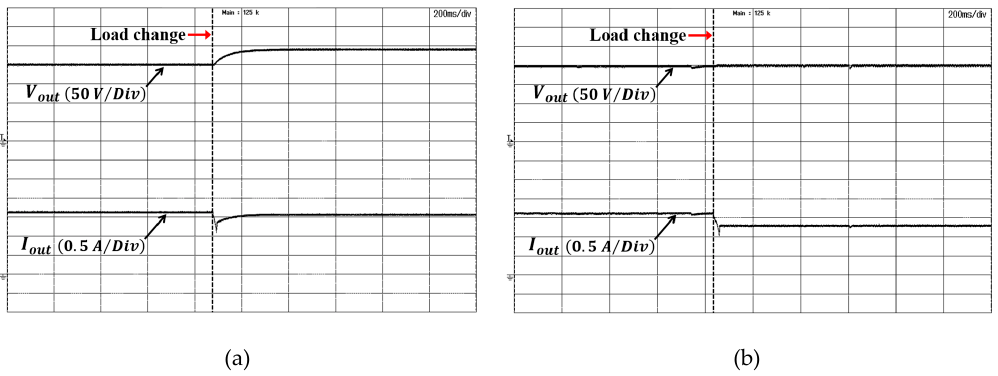
Figure 18. Experimental results of the output voltage regulation under load change: ( a ) Without output voltage regulation; ( b ) With proposed controller.